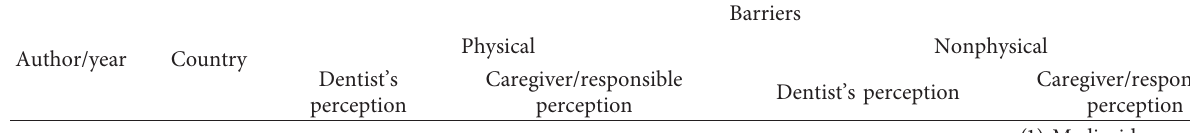
Table 4: Barriers found in the